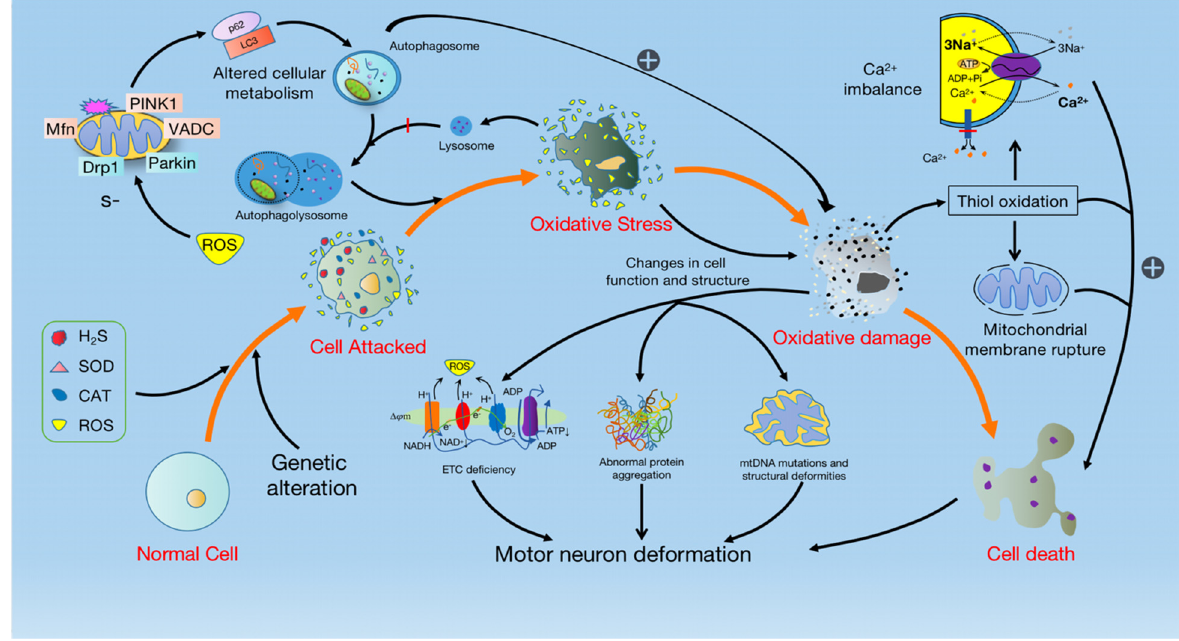
Figure 2. OS triggers mitochondrial dysfunction and leads to MN degeneration. The invasion of abnormal substances such as H2S, SOD, Catalase (CAT), and ROS causes cells to generate OS, resulting in the enhancement of PINK1-Parkin-mediated mitophagy and the accumulation of mitochondrial damage. Simultaneously, mitochondrial damage in turn causes thiol oxidation, triggering the cascading effects of Ca 2+ imbalance and mitochondrial membrane rupture, which activates cell death. In addition, the impairment of ETC due to mitochondrial damage reduces the production of NAD + and ATP, and increases the production of ROS, resulting in abnormal protein aggregation, mtDNA mutation, and structural deformity, and eventually leads to motor neuron degeneration.